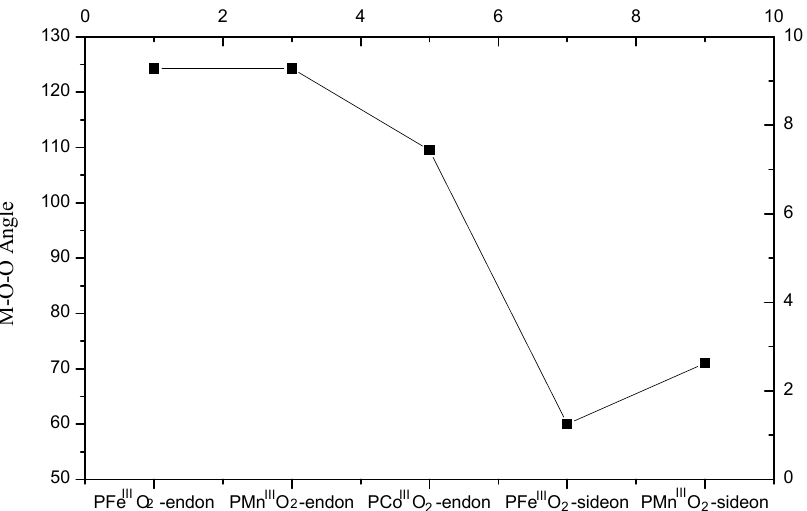
Figure 3. The M-O-O angles of side-on and end-on PM II -O 2 Figure 3. The M ‐ O ‐ O angles of side ‐ on and end ‐ on PM II ‐ O 2 intermediates.